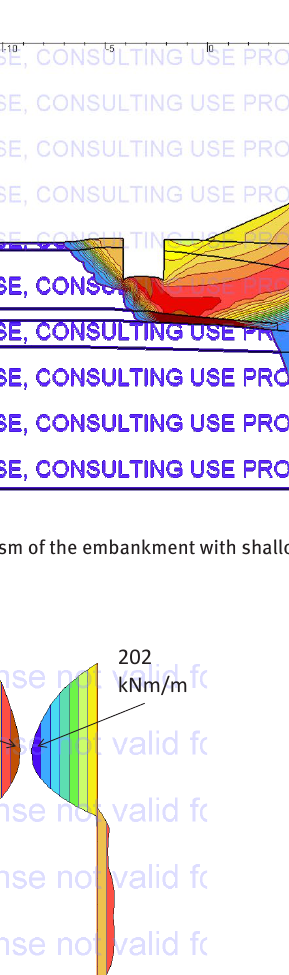
Fig. 8 Figure 8: Failure by uplift of the excavation bottom, just after culmination of the flood (T = 5.1 d).